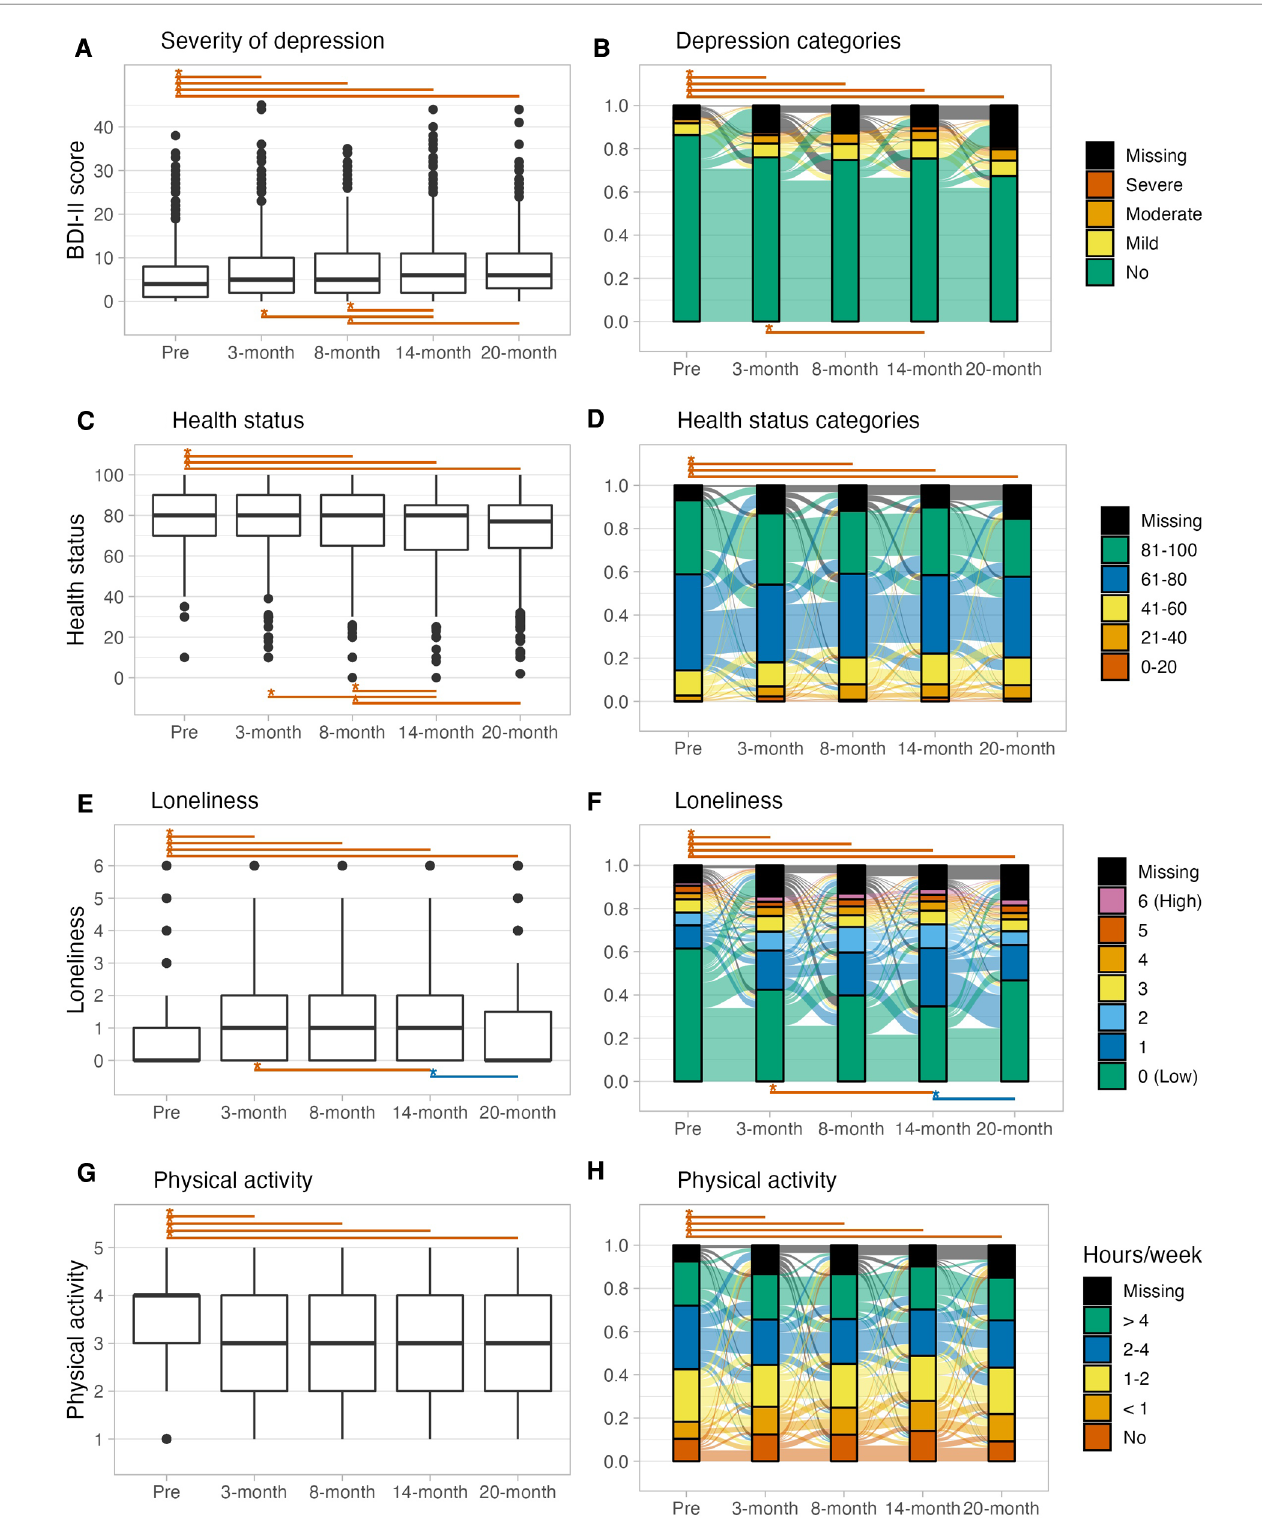
FIGURE 2 Boxplots ( A,C,E,G ) and alluvial diagrams ( B,D,F,H ) for pre-pandemic and 3-, 8-,14-, 20-month peri-pandemic assessments of the (clinically relevant) severity of depression, loneliness, health status and physical activity. Asterisks and lines indicate signi fi cant ( p <0.00139, Bonferroni corrected) differences between timepoints (red: deterioration, blue: improvement). Tests for depression and health status in the alluvial diagram are based on categorized data as shown in the